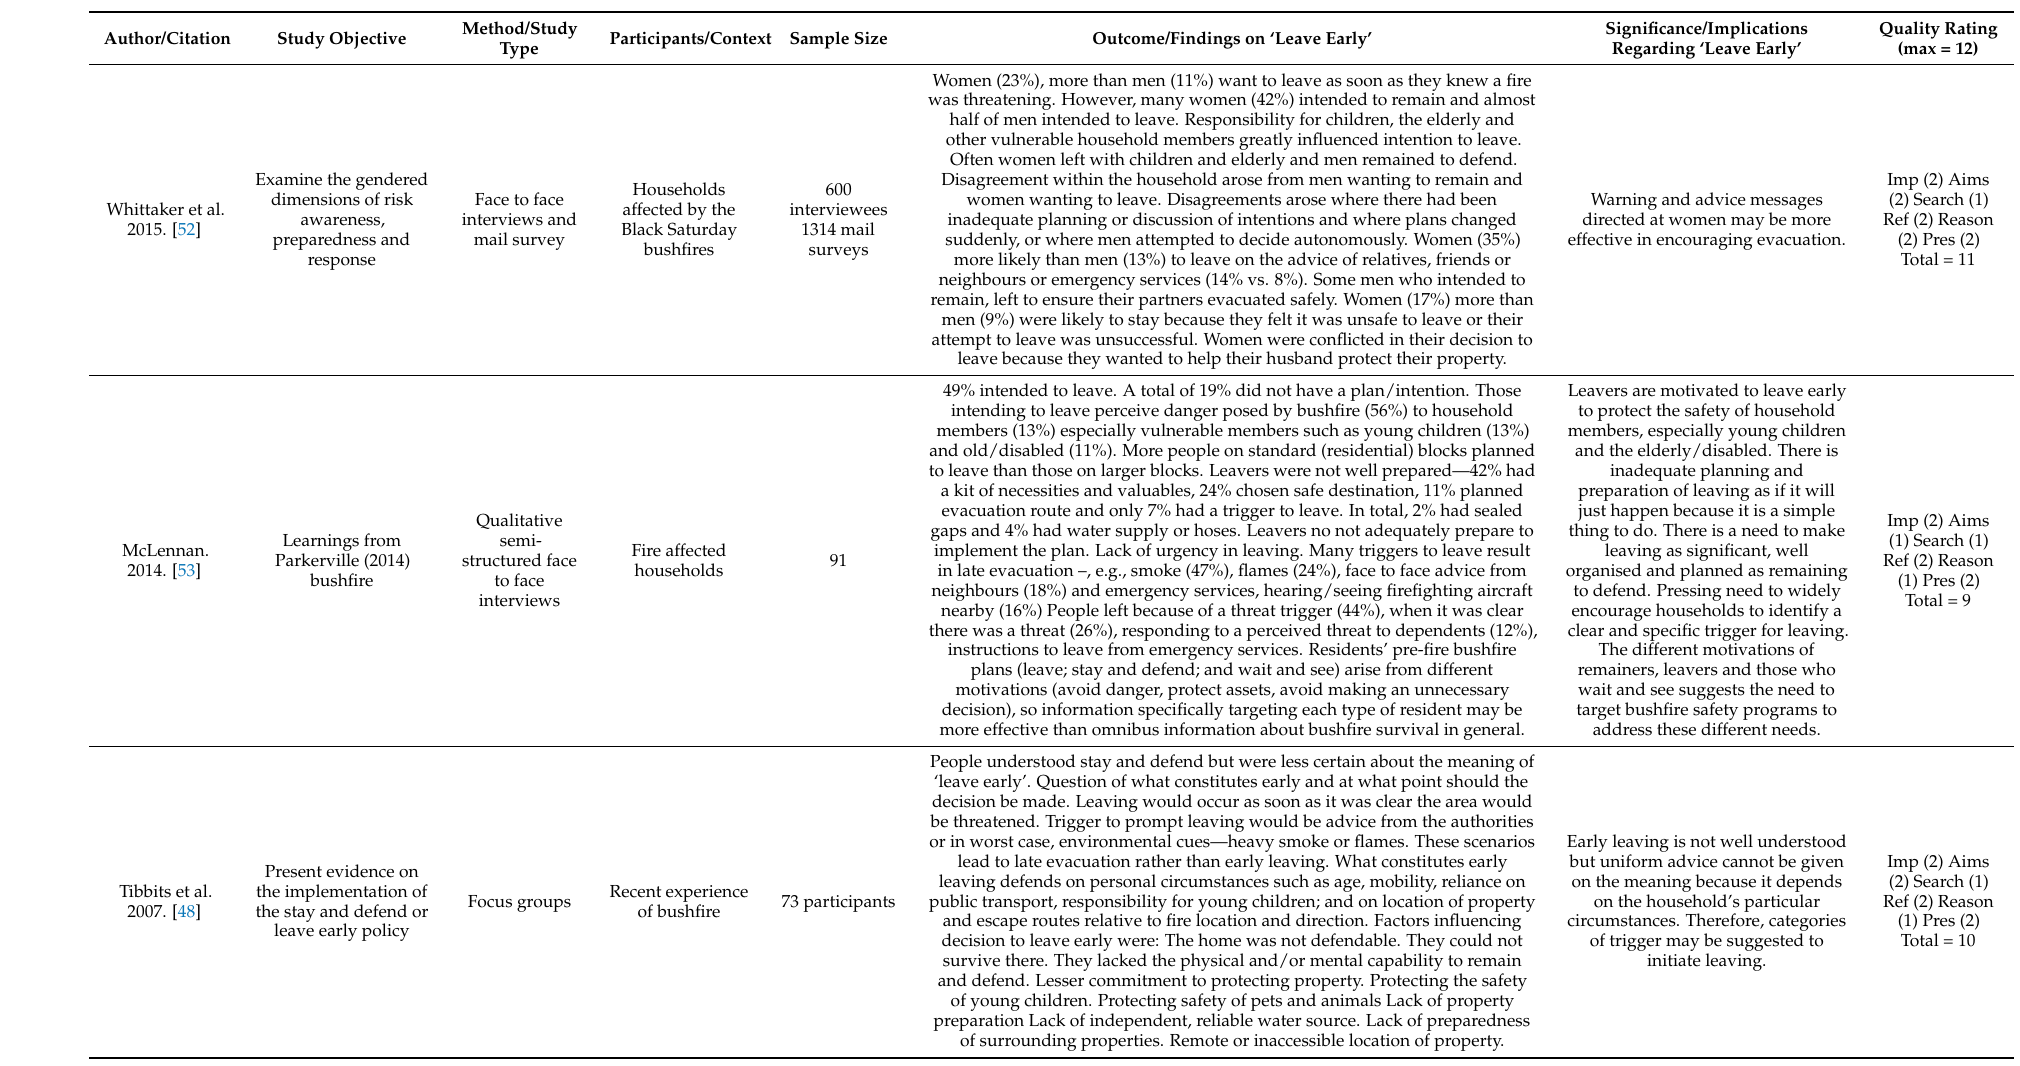
Table 2. Primary studies of ‘leave early’ in bushfire (or